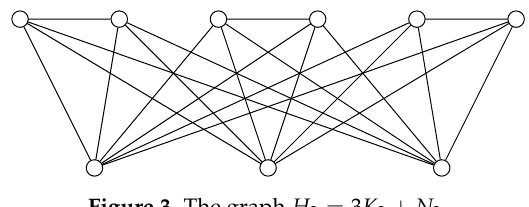
Figure 3. The graph H 2 = 3 K 2 + N 3